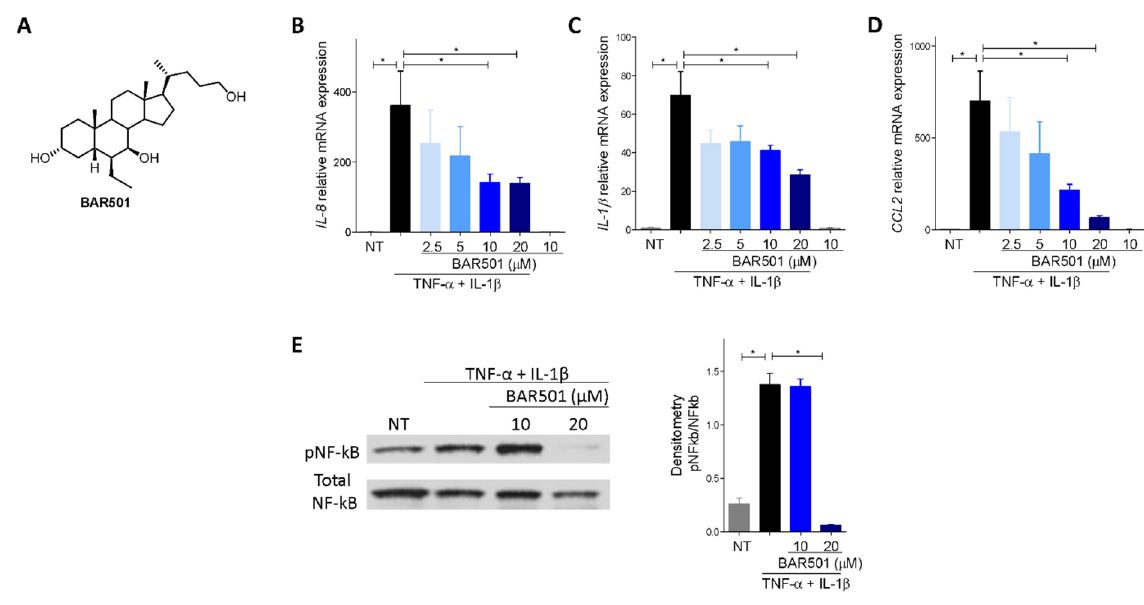
Figure 7. Effect of activation of GPBAR1 on the colorectal adenocarcinoma HT29 cell line. ( A ) Chem- ical structure of BAR501, a selective agonist of GPBAR1. ( B ) Quantitative real-time PCR analysis of cytokines ( B ) Il-8 and ( C ) Il-1 β and chemokines ( D ) Ccl2 in Ht29 cell line activated with TNF- α 100 ng/mL an IL-1 β 25 ng/mL for 24 h alone or in combination with BAR501 at different concentra- tion (2.5, 5, 10, 20 µ M). The data are normalized to GAPDH mRNA. Results are expressed as mean ± SEM; * p < 0.05. ( E ) Western blot analysis of p-NF-kb levels in HT29 cells in presence of BAR501 at 10 and 20 µ M and densitometric analysis performed with Image J from blots corresponding to all samples, data are presented as mean ± SE relative to total NF-kb